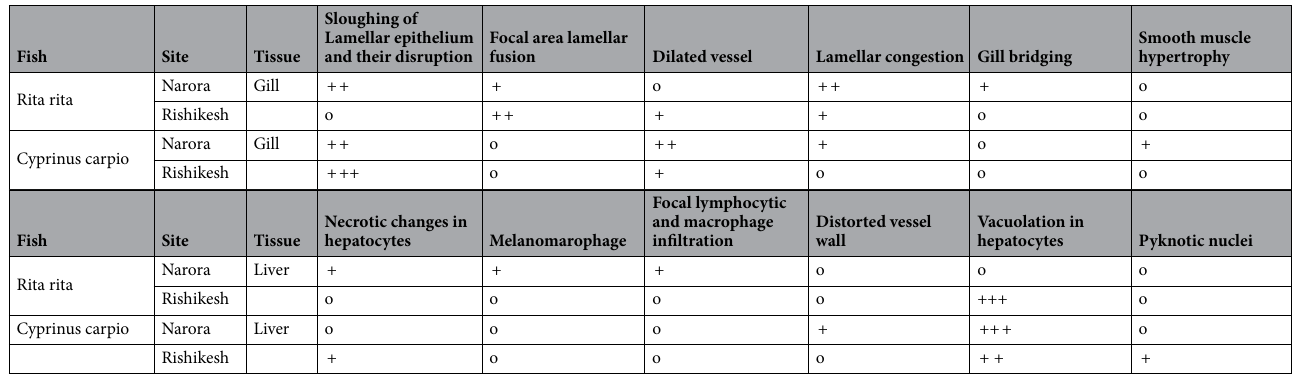
Table 2. Summarized histopathological changes in gill and liver tissues of Rita rita and Cyprinus carpio from Narora and Rishikesh site of river Ganga. O absent, + low frequency, ++ frequent, +++ very